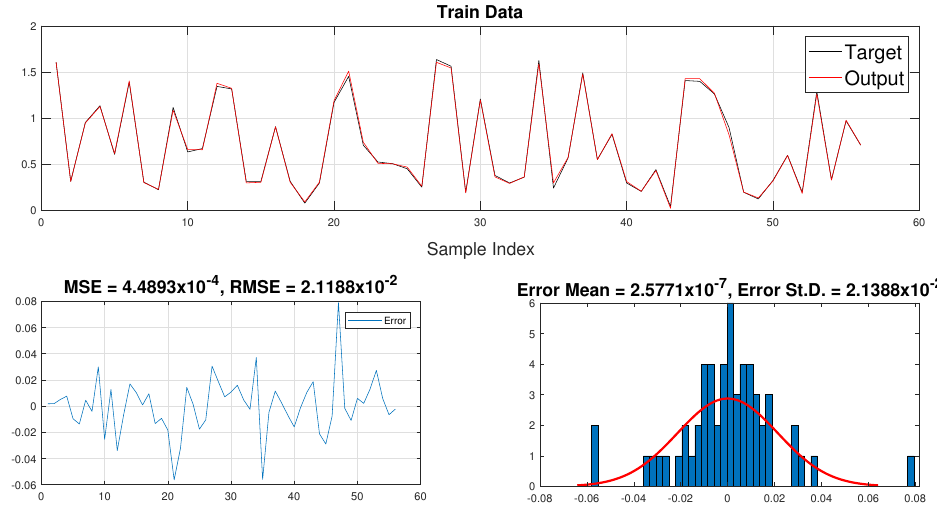
Figure 10. SISO pH–enzyme activity FIS model training. The mean error of the pH–enzyme activity model for all data is 0.000998, Error STD is 0.0208, and the RMSE is 0.0206, indicating the developed FIS model successfully captured the relation between pH and enzyme activity, as shown in Figure